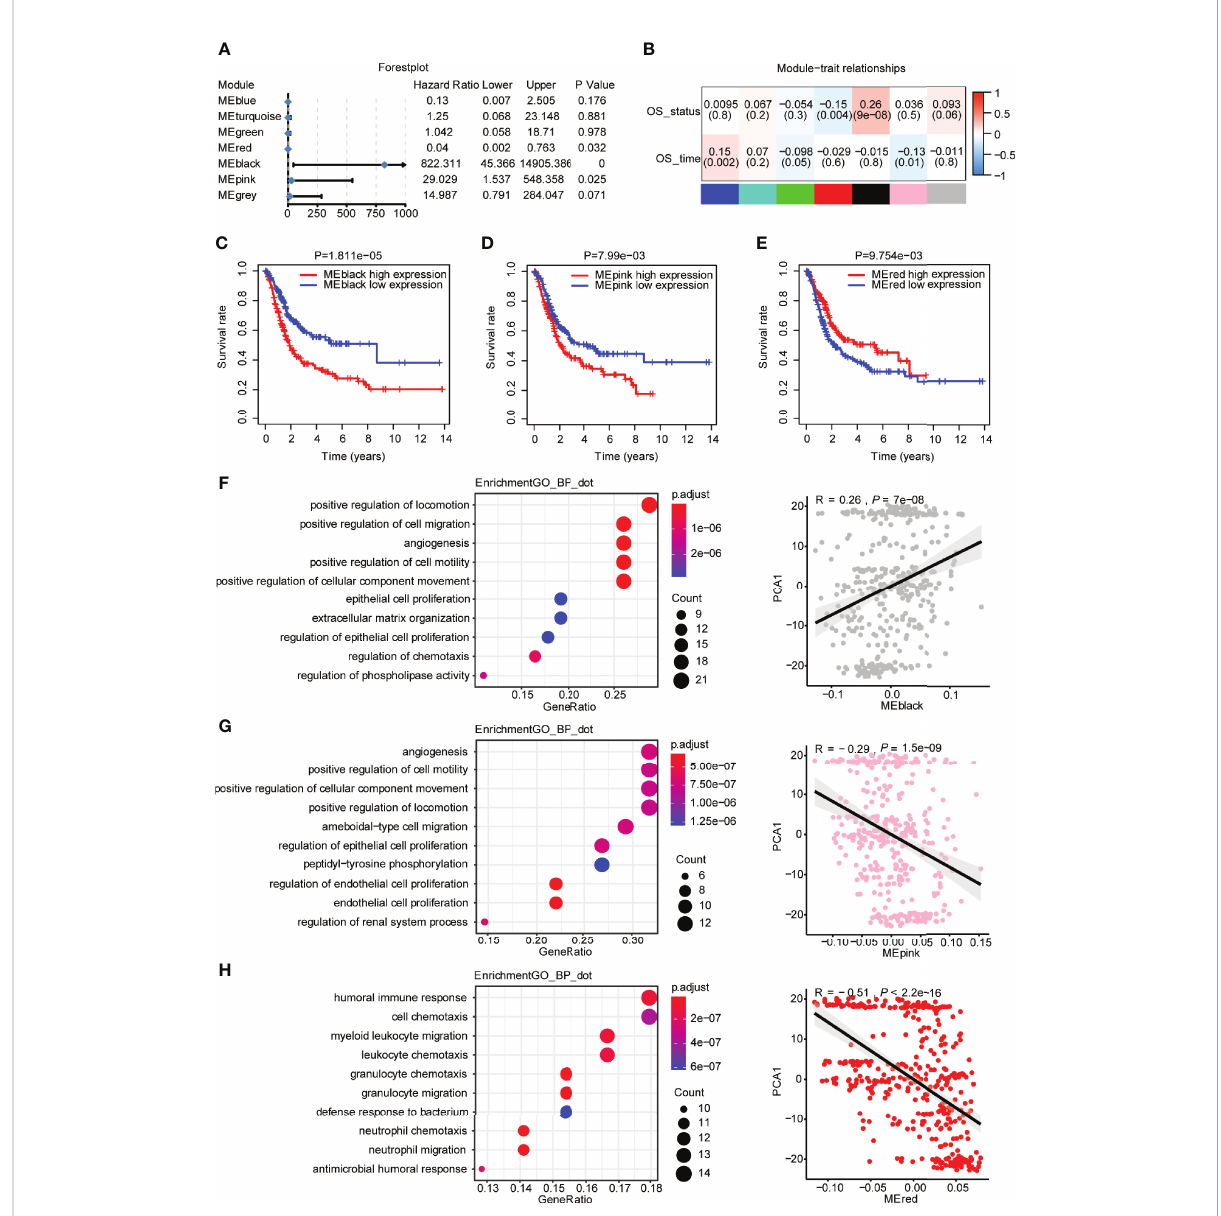
FIGURE 8 Identi fi cation of hub genes of bladder urothelial carcinoma based on immune genes. (A) Forest plot of univariate Cox analysis of seven modules of bladder urothelial carcinoma. (B) The degree of correlation between different modules and survival information is shown. (C) Prognostic value of the black modules with the median as a cutoff. (D) Prognostic value of the pink modules with the median as a cutoff. (E) Prognostic value of the red modules with the median as a cutoff. (F) Dot plot of the top 10 biological processes in terms of the black module. Correlation between the black module and principal component 1. (G) Dot plot of the top 10 biological processes in terms of the pink module. Correlation between the pink module and principal component 1. (H) Dot plot of the top 10 biological processes in terms of the red module. Correlation between the red module and principal component